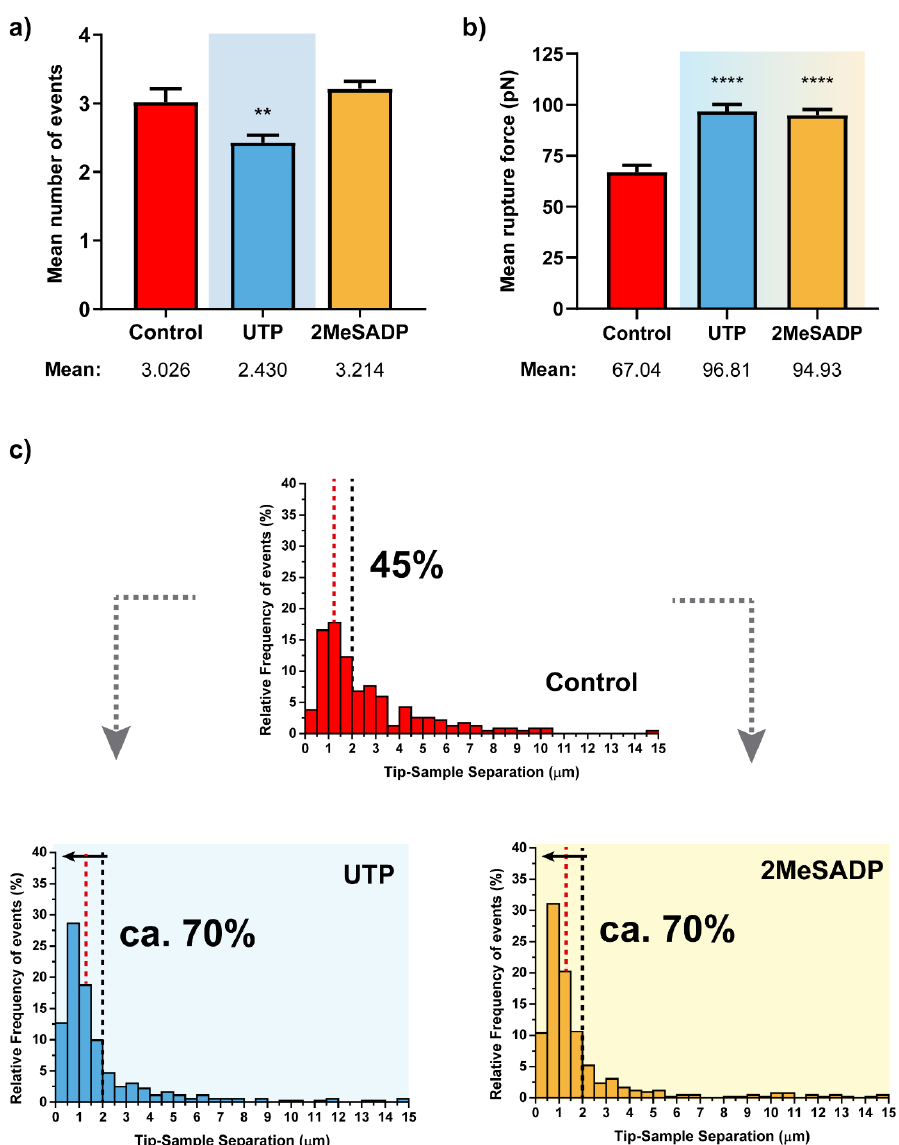
Figure 4. Rupture event and tether characterization for the respective UTP and 2MeSADP treatments on astrocytes ( N > 30). Figures ( a ) and ( b ) show the mean ±S.E.M. values for the number of tethers per curve and the corresponding rupture forces. ( c ) Pulling distance- dependent relative frequency of appearance of full rupture events under the different conditions. Dashed lines highlight the maximum probability to find rupture events in control astrocytes (red) and the position at which observation of the 70% of the tethers in UTP-treated cells takes place, with the respective percentages in each case. Statistically relevant variations p < 0.01 and p < 0.0001 are highlighted by ** and ****, respectively.